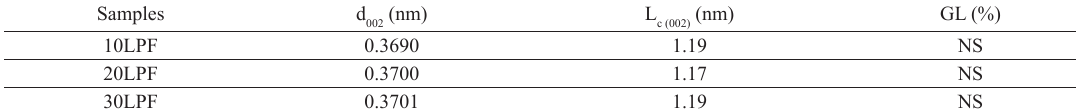
Table 4. Interlayer spacing, and crystallite height values of carbon derived from plain LPF resins after thermal treatment at 1000 ºC for 5h under reducing environment.